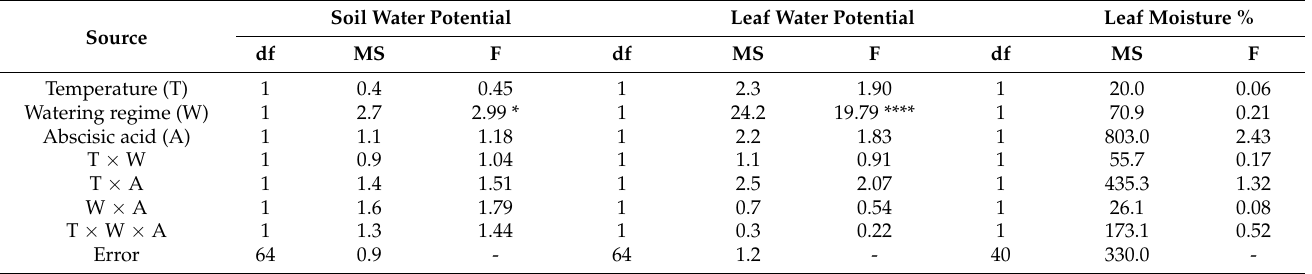
Table 15. Analysis of variance for the effects of temperature, watering regime, abscisic acid, and their interactions on water potential and moisture of tomato plants.